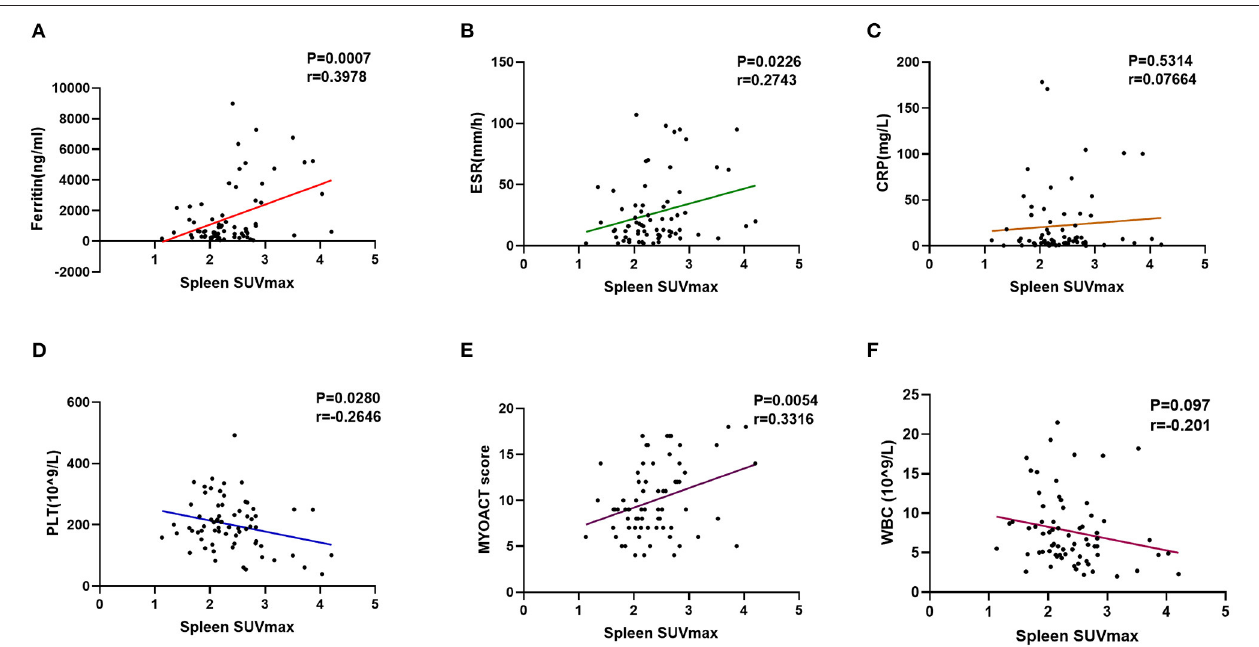
FIGURE 5 | Evaluation of abnormal spleen FDG uptake in the patients with anti-MDA5 + DM. (A) Correlation between ferritin and spleen SUVmax. (B) Correlation between ESR and spleen SUVmax. (C) Correlation between CRP and spleen SUVmax. (D) Correlation between PLT and spleen SUVmax. (E) Correlation between MYOACT score and spleen SUVmax. (F) Correlation between WBC and spleen SUVmax. FDG, 18 F-fluorodeoxyglucose; MDA5, melanoma differentiation associated protein 5; DM, dermatomyositis; SUVmax, maximum standardized uptake value; ESR, Erythrocyte sedimentation rate; CRP, C-reactive protein; PLT, platelet; MYOACT, Myositis Disease Activity Assessment Visual Analog Scales; WBC, white blood